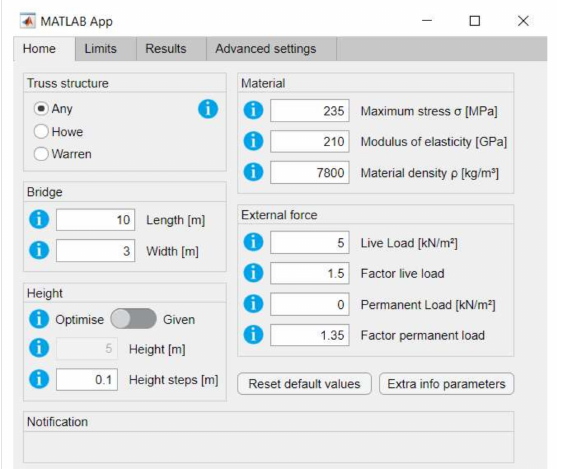
Figure 1. Software home